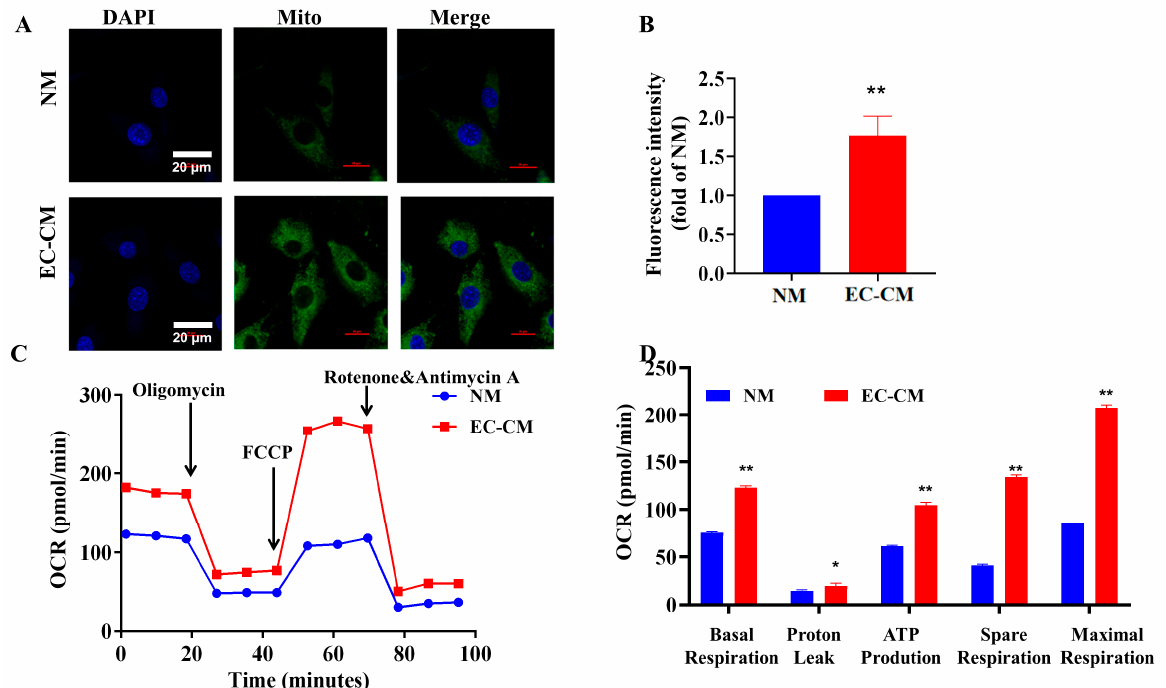
Figure 6. EC-CM treatment enhances the mitochondrial biogenesis and respiratory function of adipocytes in vitro. Mitochondrial contents were evaluated by a mitochondrial fluorescent probe dye under confocal microscopy ( A , B ). Mitochondria OCR curves ( C ) and their quantification analysis ( D ) under basal or stress conditions were prepared by a Seahorse XF Analyzer in 3T3-L1 adipocytes. Data are presented as mean ± SEM from three independent experiments ( n = 3) and were analyzed by an unpaired two-tailed Student’s t -test. *p < 0.05, **p < 0.01, vs. NM group. EC-CM: conditional medium from endothelial cells; NM: normal high-glucose completed DMEM. Scale bar in the images of Figure A: 20 μ m. OCR: oxygen consumption rate, FCCP: Carbonyl cyanide-p-trifluorometh- oxyphenylhydrazone.